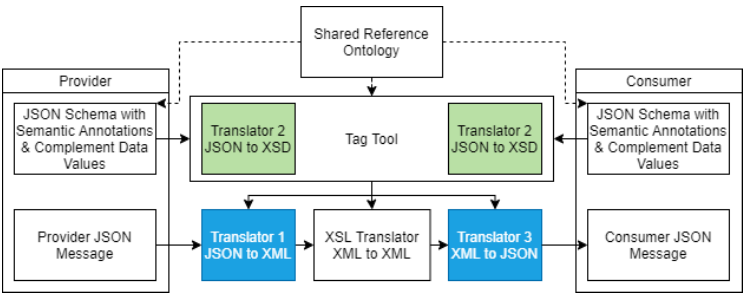
Figure 4. Extended TAG-Tool supporting JSON system